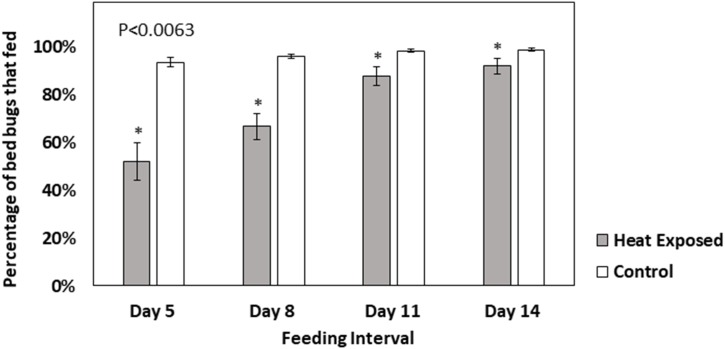
Bars representing percentage of Harlan nymphs from heat exposed (dark grey bars) and control (white bars) treatments that fed to repletion.Bed bugs that survived heat exposure at 45°C were offered blood meals at five, eight, eleven, and fourteen days after treatment (n = 40 per replicate). An equal number of control bed bugs that were not exposed to heat were offered a blood meal at the same time intervals. Statistically significant differences were found between the two treatment types and are denoted with an asterisks (*). Nonparametric Wilcoxon tests showed that at all feeding intervals feeding responses of heat-exposed and control nymphs were significantly different (P<0.05). Error bars indicate ± standard error (SE) values.